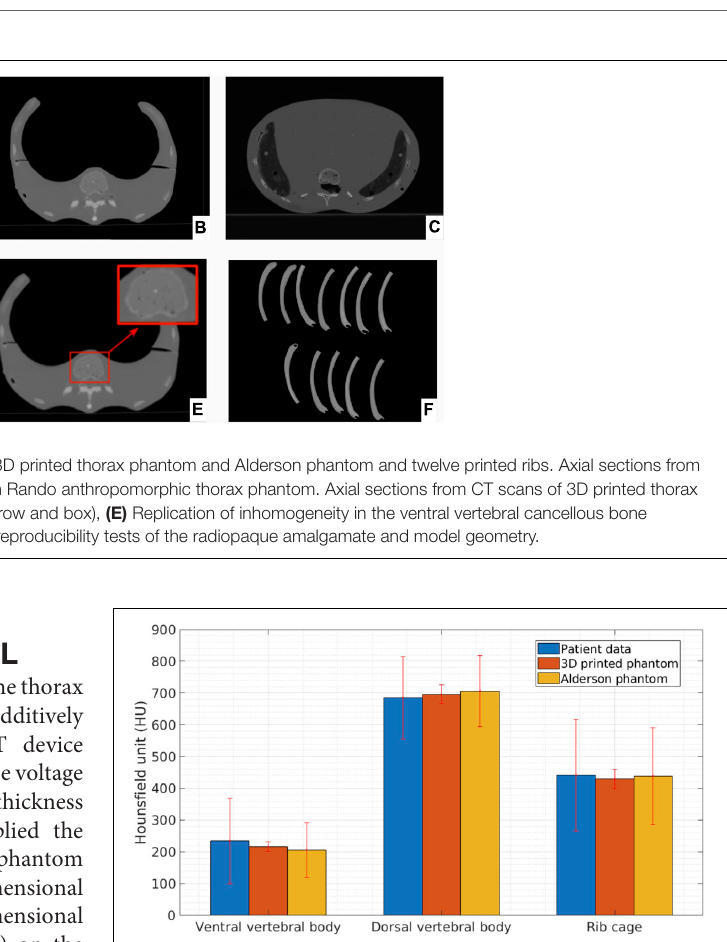
FIGURE 8 | Results from comparison of radiodensities of patient, 3D printed thorax and Alderson Rando phantom. Graph showing average and standard deviation in radiodensities (represented by Hounsfield Units, HU) of the three anatomic structures, analyzed by CT scan of patient, 3D printed thorax and Alderson Rando